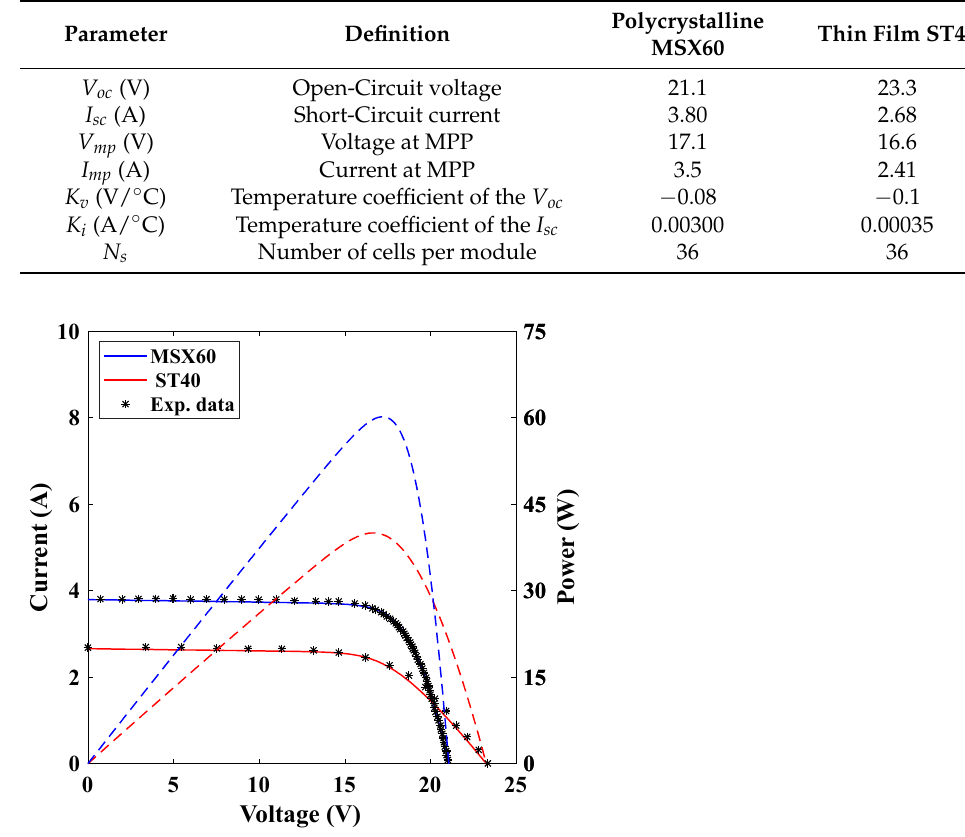
Table 2. PV panels’ electrical specifications under standard test conditions (STC).